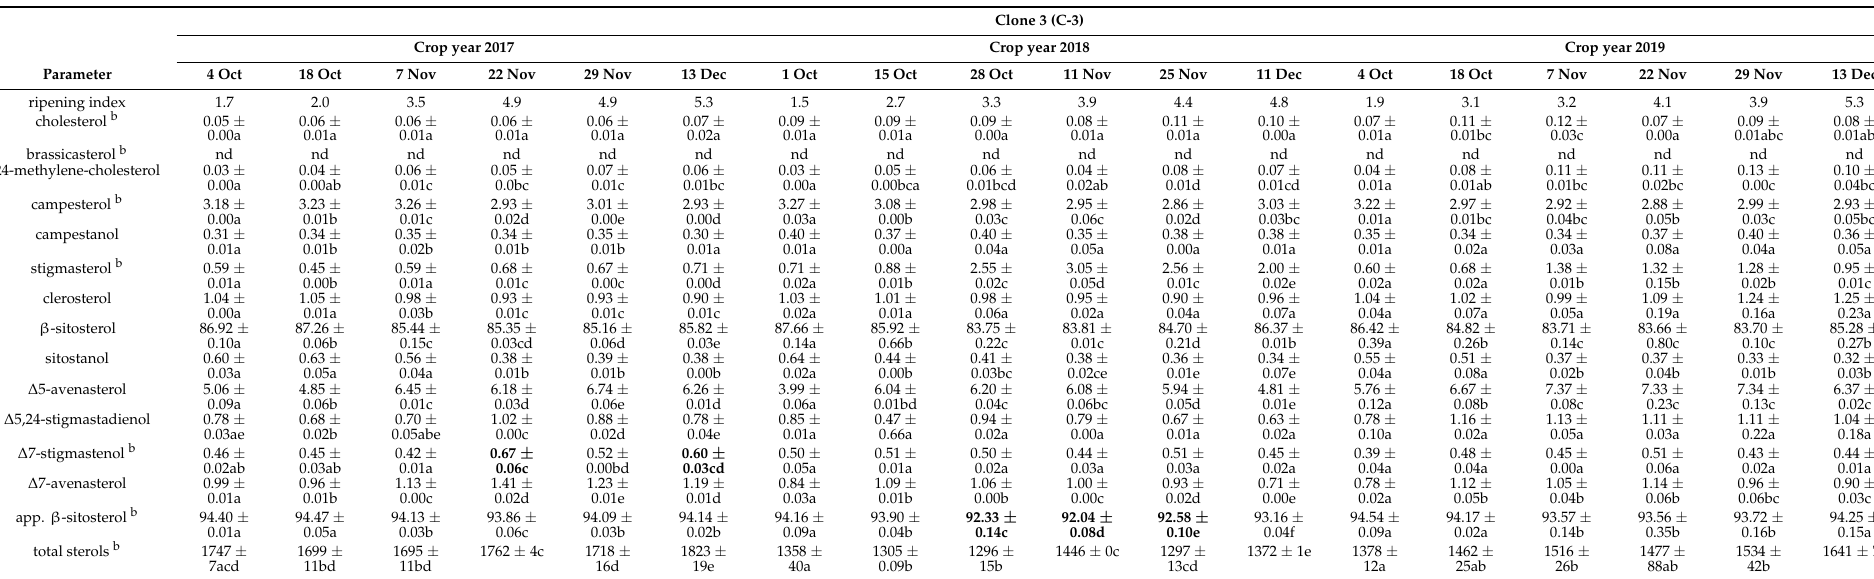
Values are mean ± standard deviation ( n =2). a Different letters for each parameter indicate significant statistical differences ( p < 0.05) among picking dates for each crop year (a–f). b Limits established by the current regulation: total sterols ≥ 1000 mg/kg; cholesterol ≤ 0.5%; brassicasterol ≤ 0.1%; campesterol ≤ 4.0%; stigmasterol ≤ campesterol; ∆ 7-stigmastenol ≤ 0.5%; app. β -sitosterol ≥ 93.0%. Values in bold: non-compliance. Not detected =